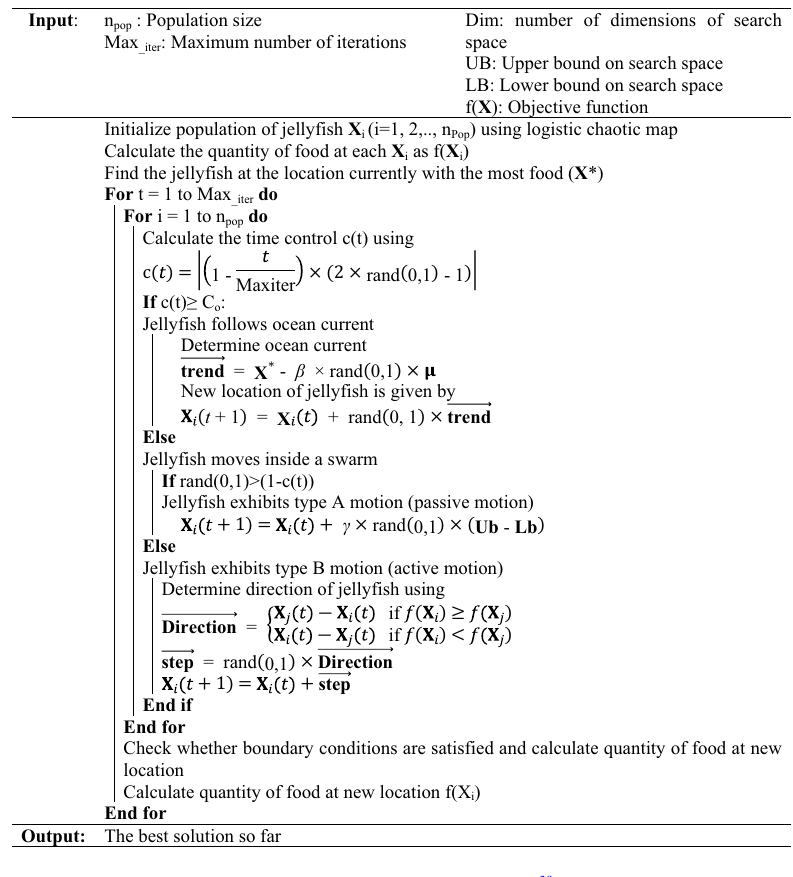
Figure 3. Pseudocode of JSO algorithm, adapted from Ref. 39